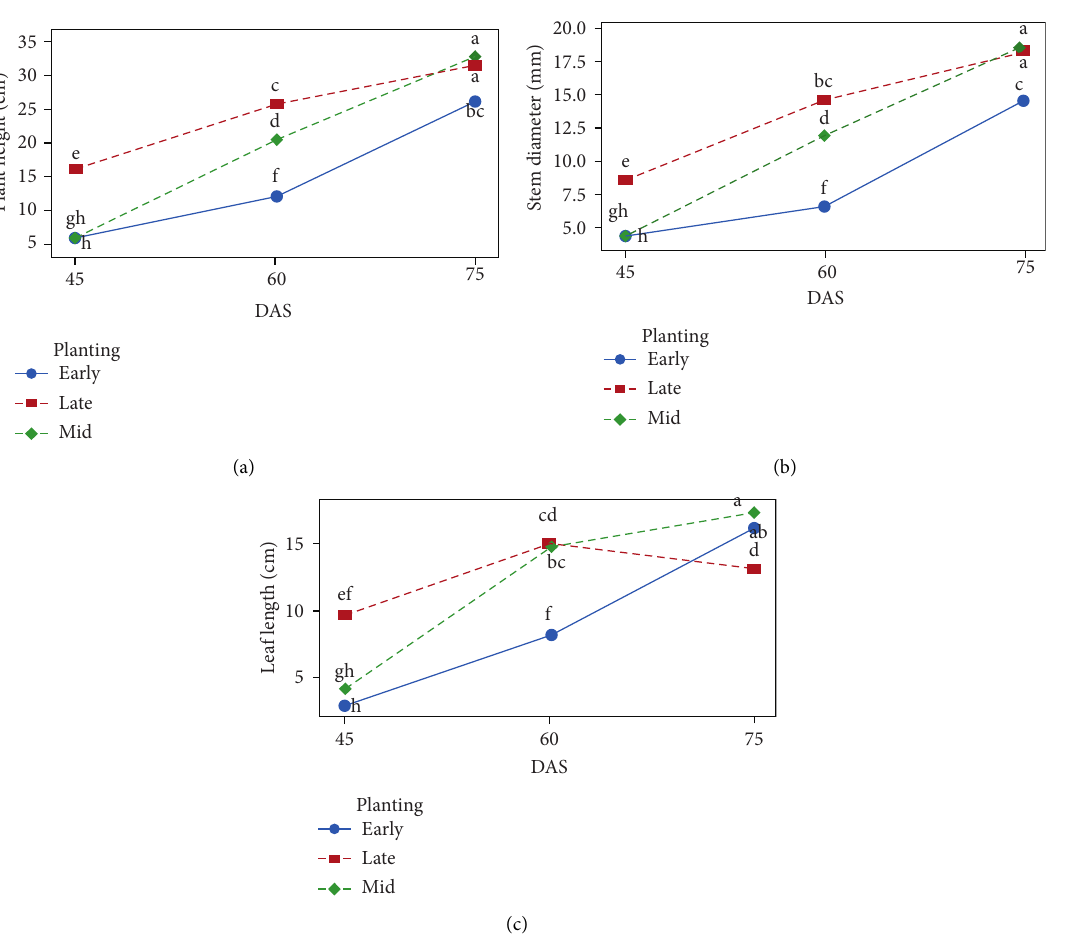
Figure 1: Interaction effects of planting time and days after sowing (DAS) on (a) plant height (cm), (b) leaf length (cm), and (c) stem diameter (mm). Means sharing the same letter are not significantly different at p < 0 .